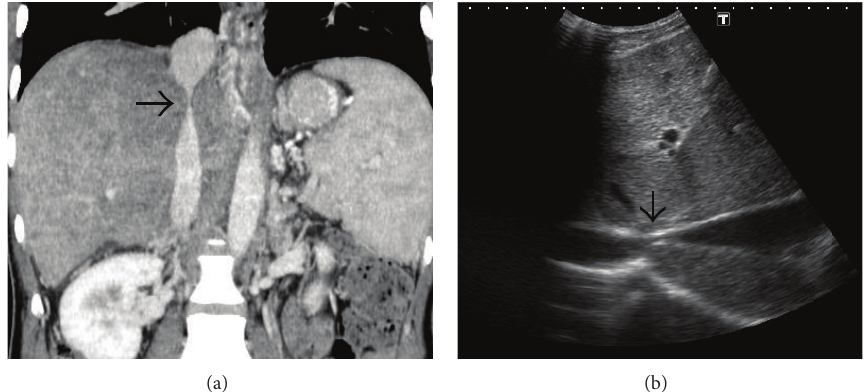
Figure 16: Coronal CECT (a) and gray-scale US (b) image demonstrating compression of intrahepatic IVC (arrows) caused by hypertrophy of the caudate lobe.